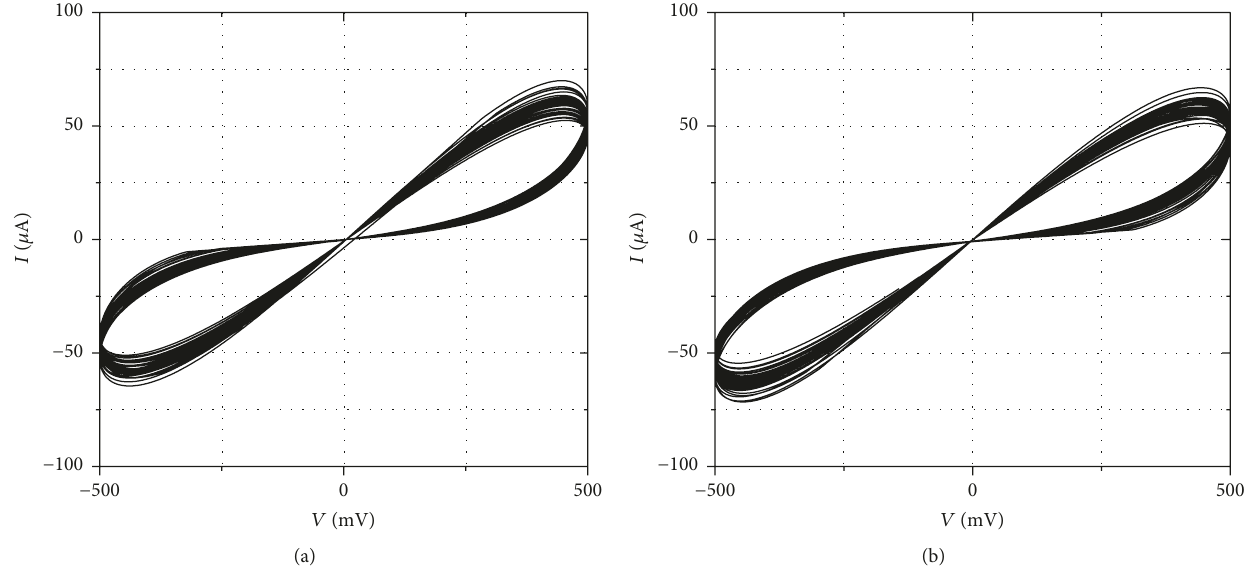
Figure 4: Monte Carlo analysis of the emulator for all passive elements: (a) the incremental type and (b) the decremental type.